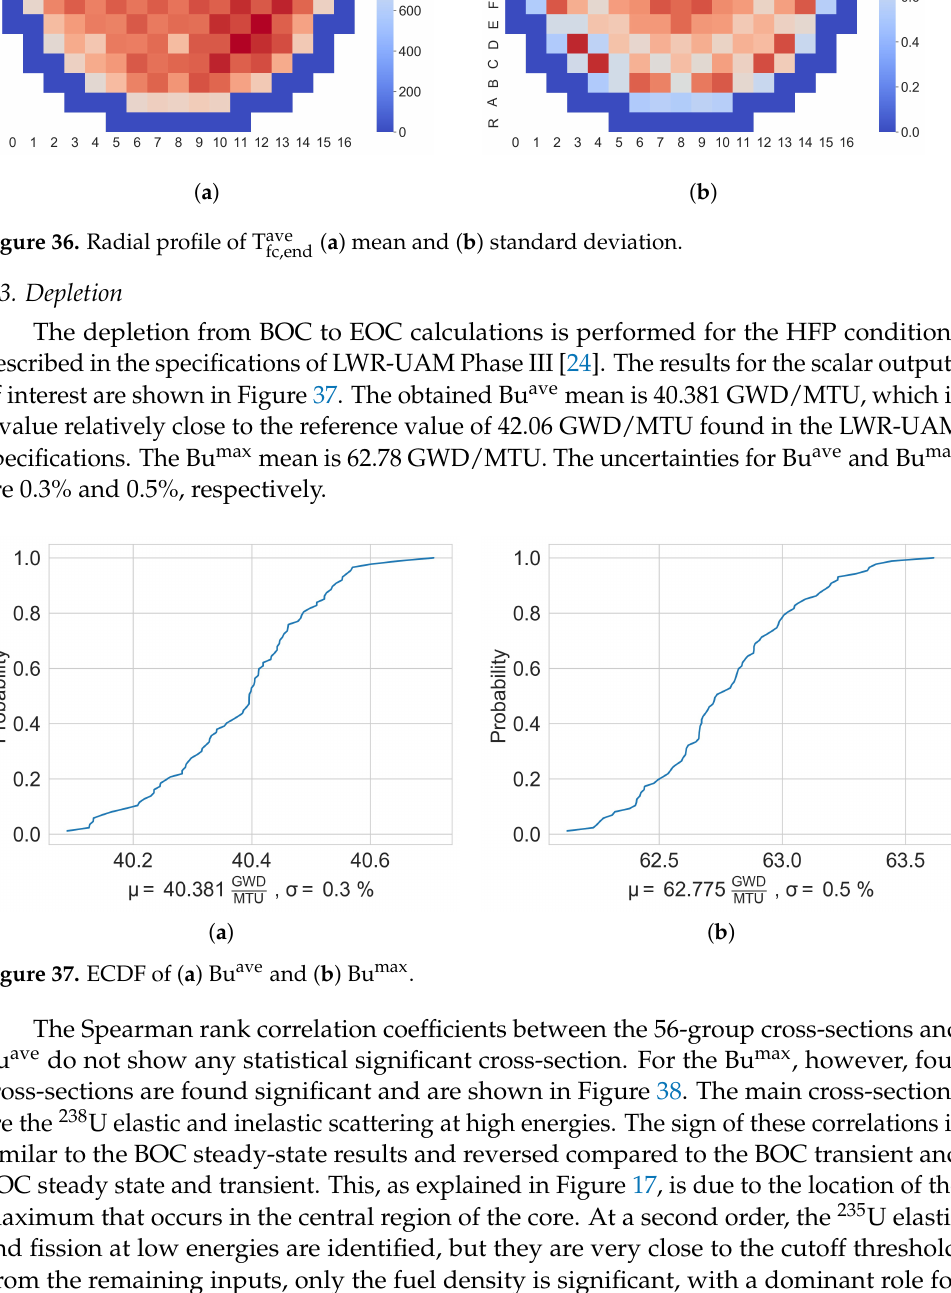
Figure 36. Radial profile of T ave